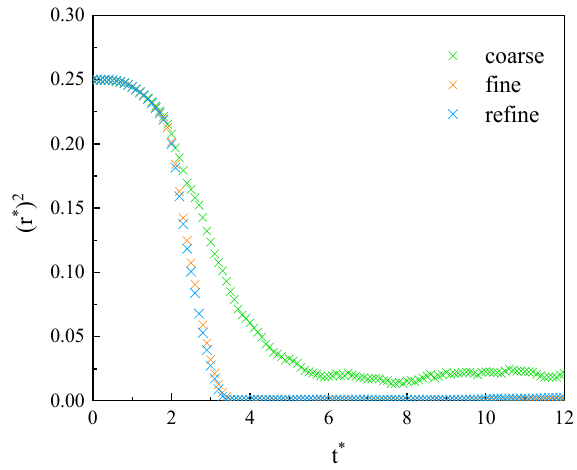
Figure 4. Residual radius of droplet vaporization at different grid encryption levels.